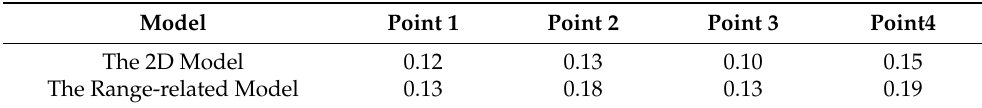
Figure 7. ( a ) The observed deformation in the interferograms of four points in the Linjiaping area. ( b ) The deformation compensated by the range-related model. ( c ) The deformation compensated by the 2D model. Table 3. The standard deviations of the residual phase for the four points in time series obtained by the range-related model and the 2D model